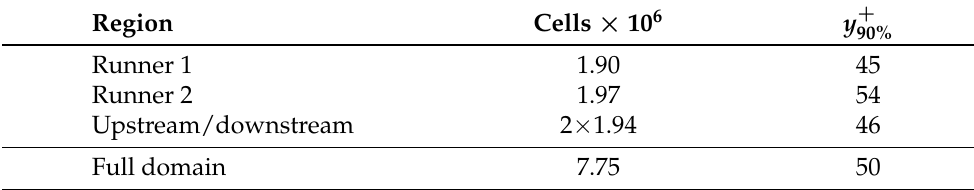
Figure 3. Computational mesh regions, Runner 1 (red) and Runner 2 (blue). ( a ) Surface mesh of one blade passage. ( b ) Zoomed-in view of the refined mesh regions and surfaces of the runners. Table 2. Mesh